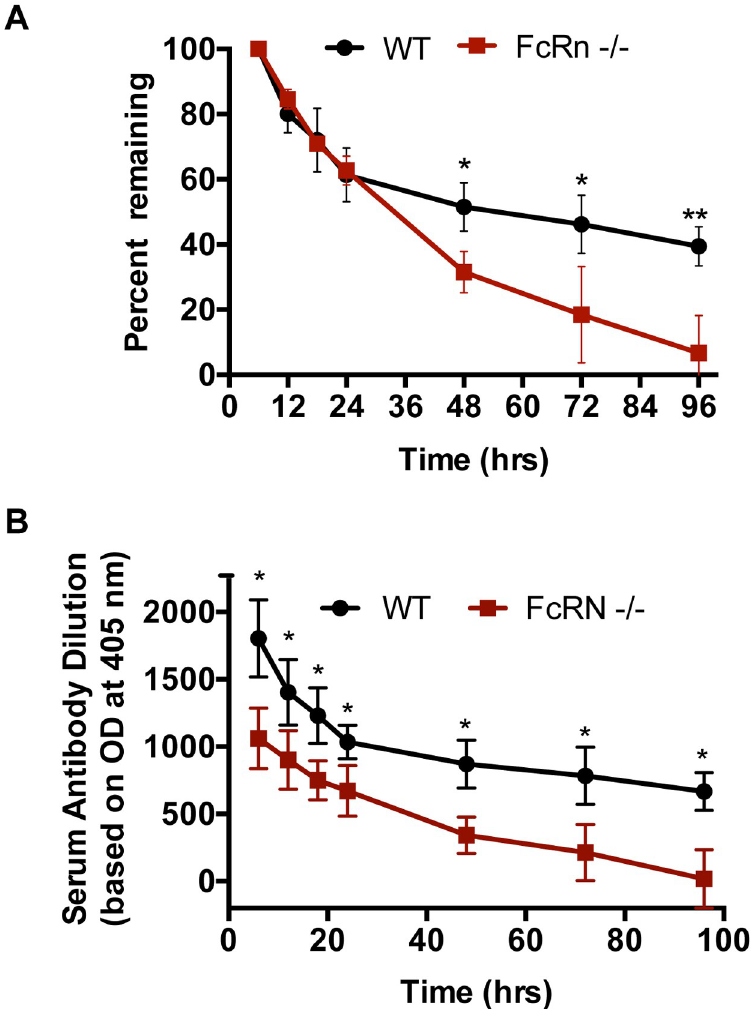
Fig 3. Average serum clearance kinetics of mAb 3D11 in FcRn -/- and control C57Bl/6J mice. At the indicated time points following IV inoculation of 50 μ g of mAb 3D11, blood was collected retro-orbitally and the level of mAb 3D11 in the serum was determined by ELISA. (A) The percentage of mAb 3D11 remaining at each time point in WT and FcRn -/- mice was determined as a ratio with the amount of serum mAb 3D11 at the respective 6 hr value. Shown is the mean ± standard deviation of 3 to 4 mice per time point. (B) Non-normalized serum clearance data for WT and FcRn-/- mice is shown. Absorbance was measured in serial dilutions of serum and the dilution corresponding to an absorbance of 1.0 is shown. No comparisons between WT and FcRn-/- mice reached statistical significance. Statistics for both panels compared the percent mAb 3D11 remaining (panel A) or the amount of mAb remaining (panel B), between control and FcRn -/- mice at each time point. Statistical comparisons were performed using an unpaired t-test (two-tailed, α = 0.05).